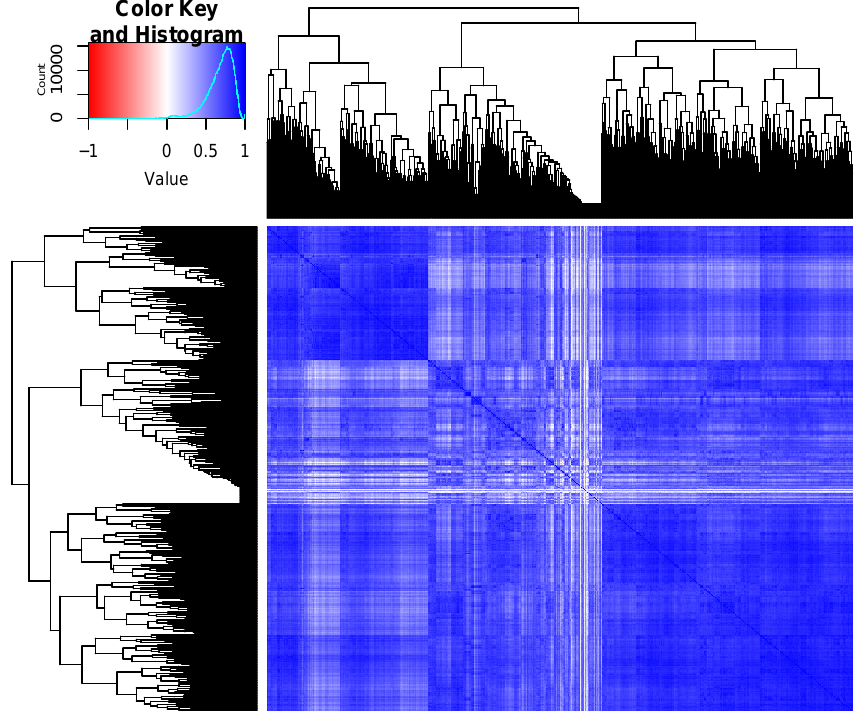
Figure 2. Visualization of the permuted correlation matrix. The values of elements of the matrix R ˚ “ p r i , j q , i , j P t 1, 2, . . . , m u , are very close